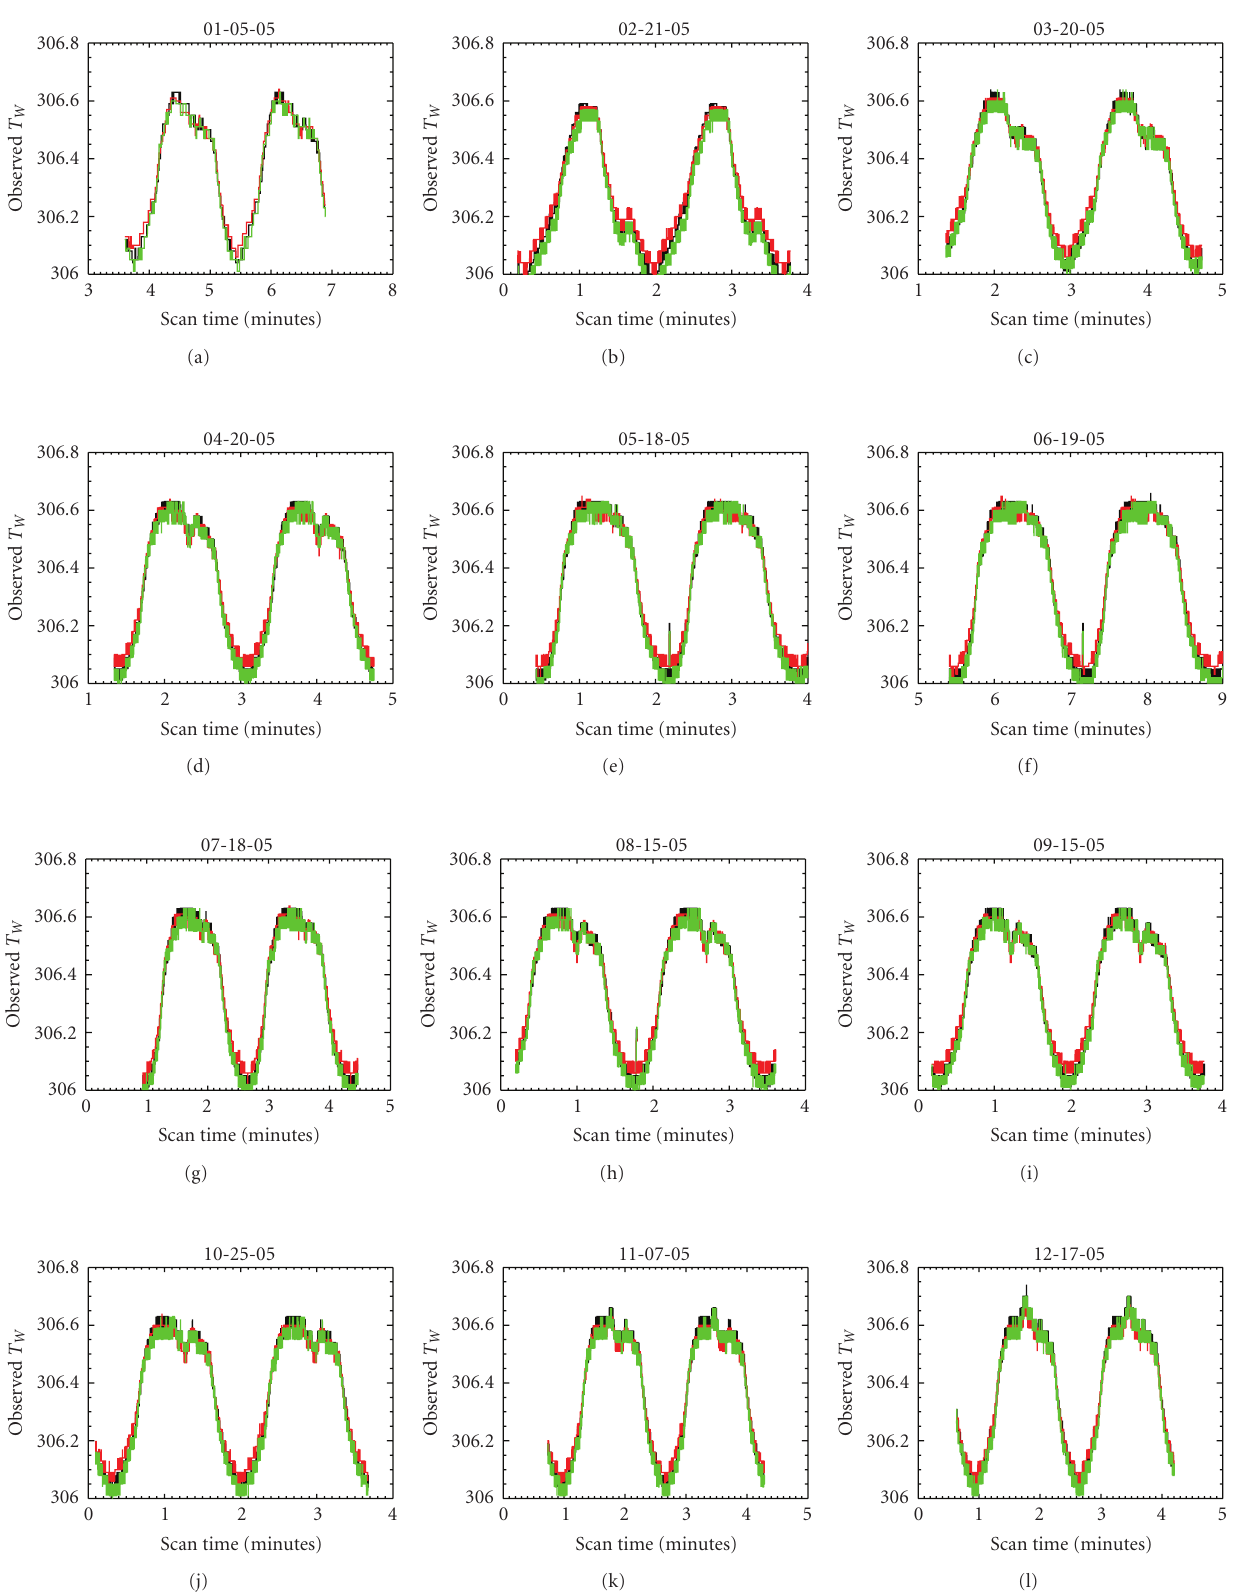
Figure 4: Time series of three PRT temperatures ( T W ) during two orbits of observations for twelve days in 2005, where the black, red, and green represent three PRT temperatures. (a) January 5. (b) February 21. (c) March 20. (d) April 20. (e) May 18. (f) June 19. (g) July 18.